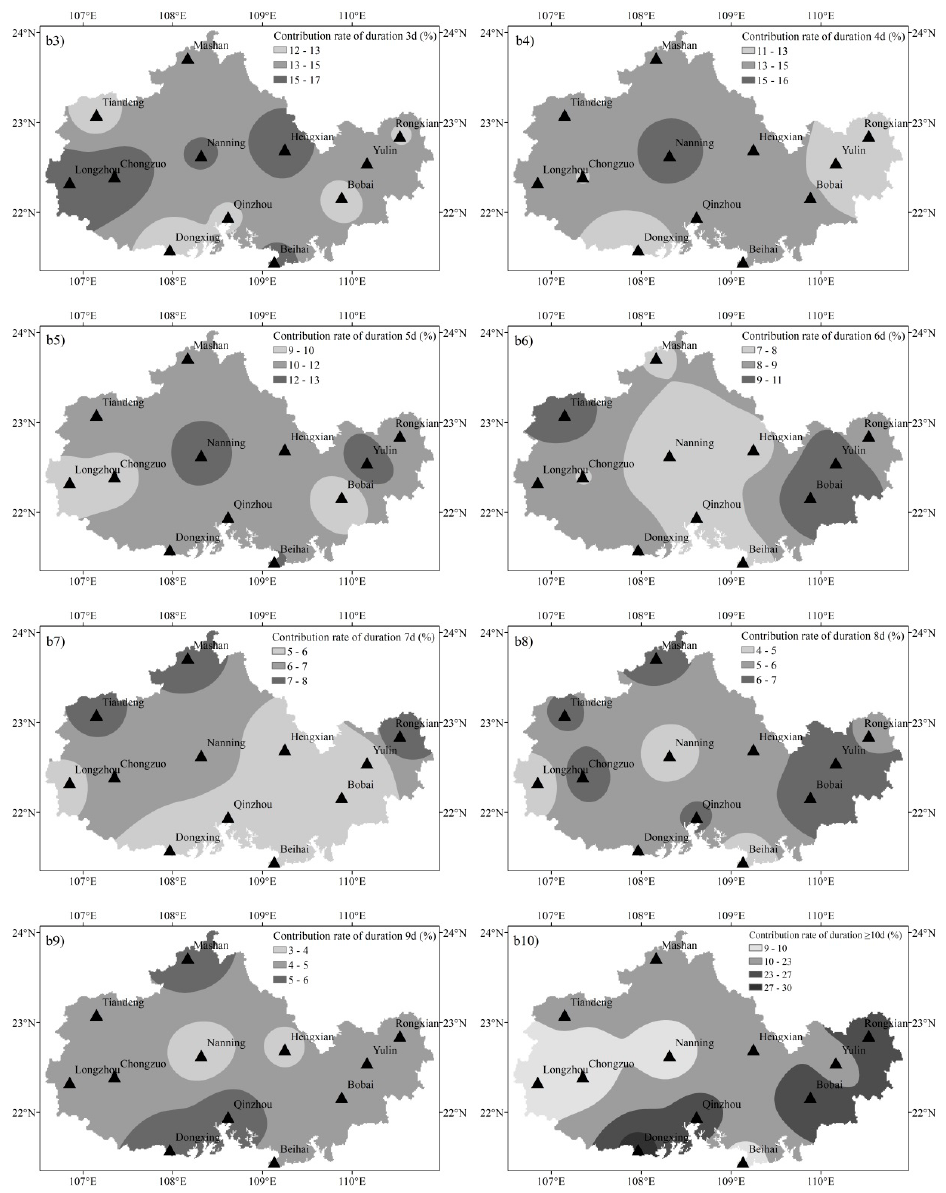
Figure A2. Spatial distribution of contribution rate of di ff erent precipitation durations in rainy season in the Beibu